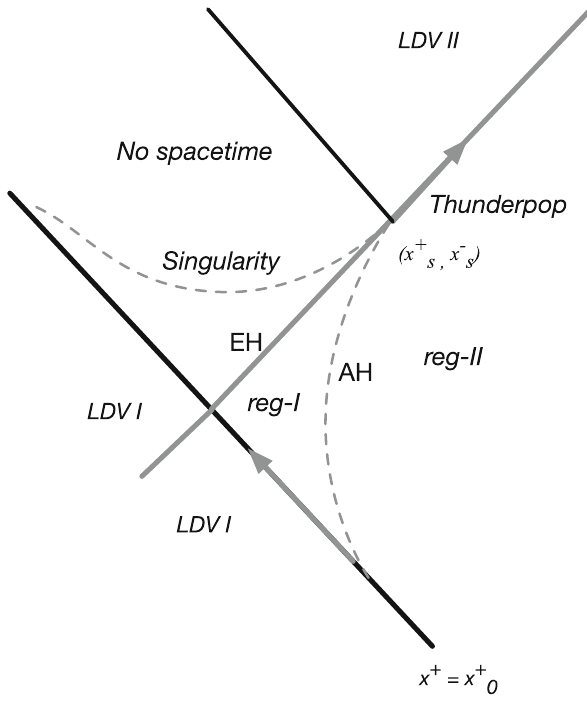
Fig. 1 RST spacetime in Kruskal coordinates where a black hole is created due to the matter collapse and evaporated due to the Hawking